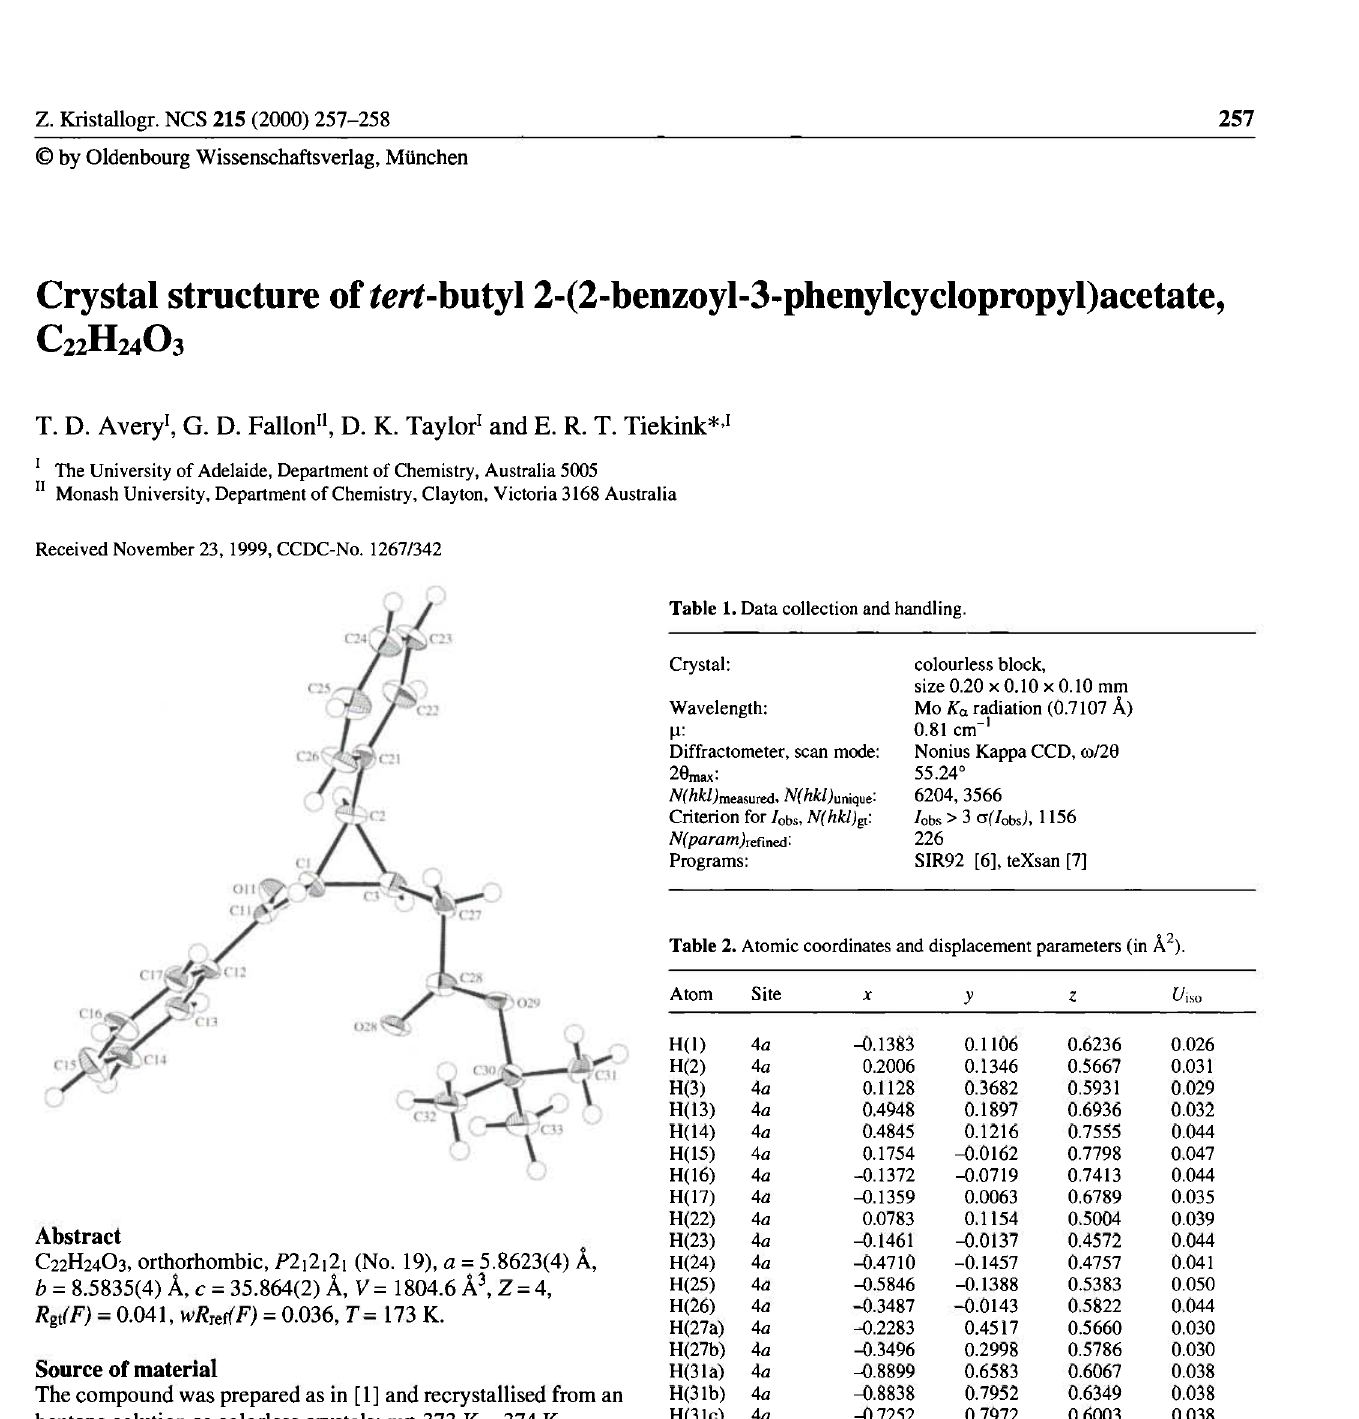
Table 2. Atomic coordinates and displacement parameters (in Ä 2